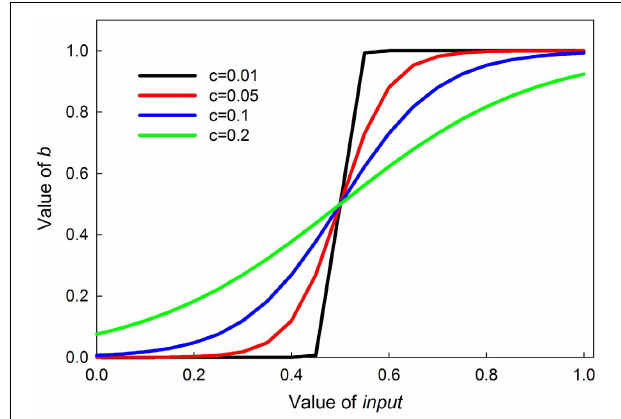
FIGURE 3 | Graphs of the value of b in Equation (2) as a function parameter c . Parameter c controls the steepness of the sigmoid; the smaller c is, the steeper the sigmoid.